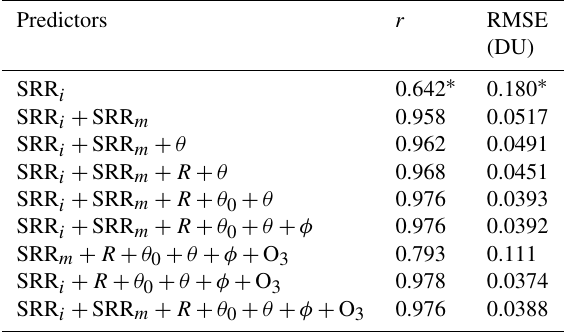
Table 1. The correlation coefficient ( r ) and root mean square error (RMSE) between the NN-analyzed OMI SO 2 SCDs (SCD NN ) us- ing different predictors and the target SCDs (SCD target ). The NNs are trained using data from 5, 10, 15, 20, and 25 July 2005. The comparisons shown here are for pixels from the same days but not included in the